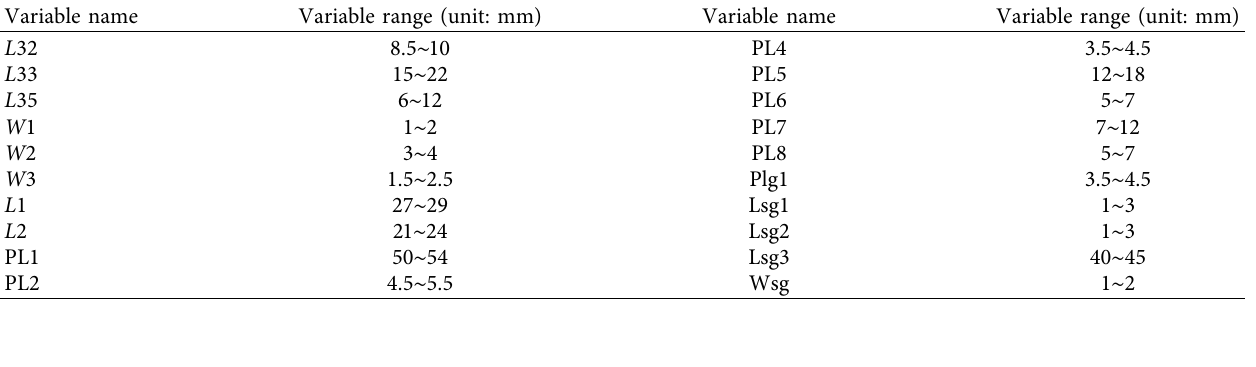
Table 1: Optimization parameters of the multiband microstrip antenna.